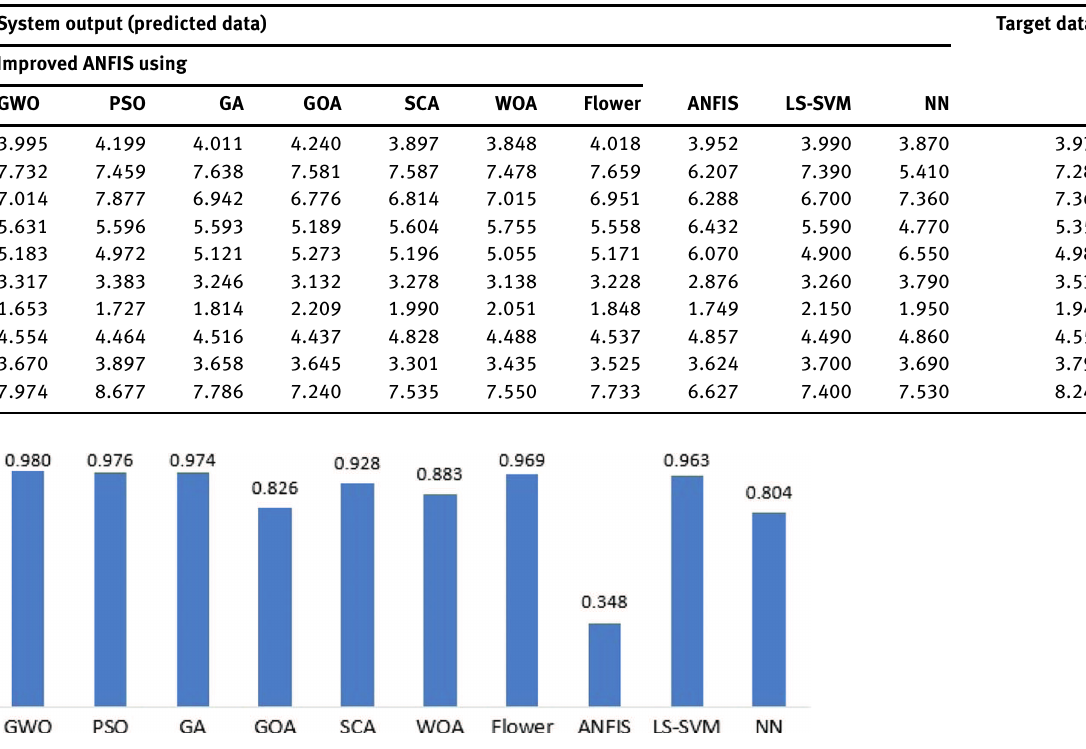
Figure 9: Accuracy of All Algorithms According to R 2